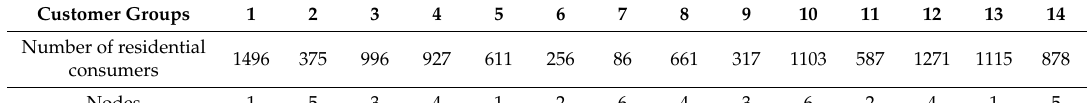
Table 1. Customer groups.